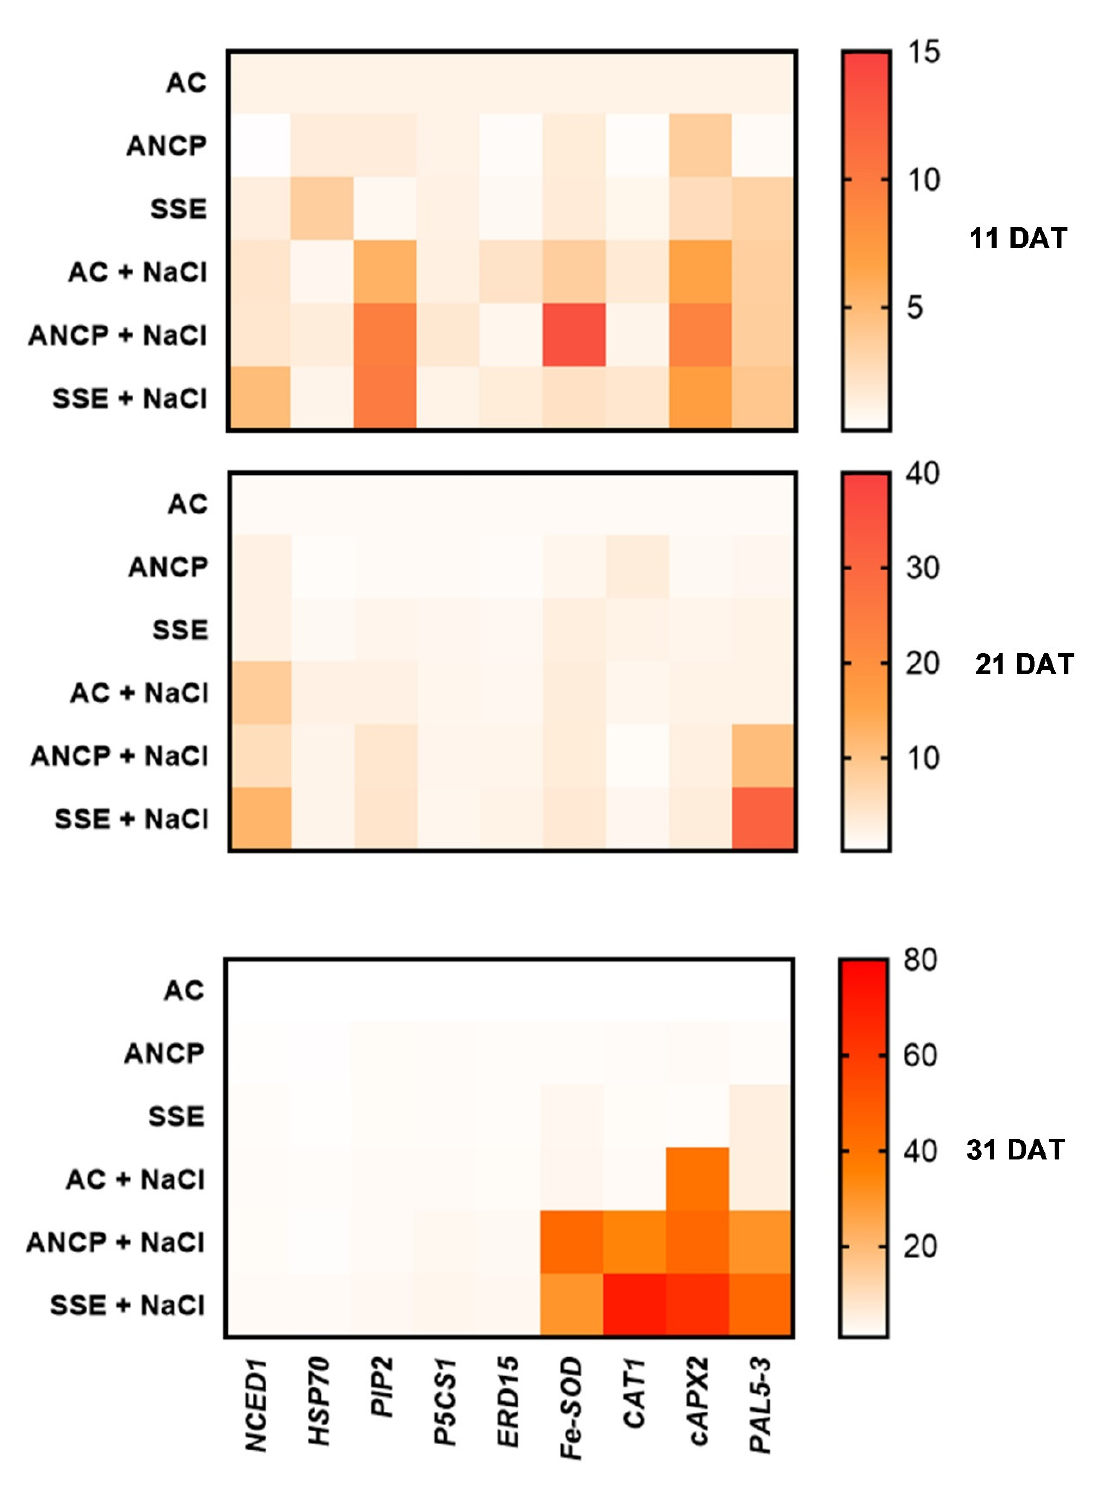
Figure 7. Heatmap of the relative expression of defense genes in leaves of tomato seedlings. DAT: Days after transplant; AC: Absolute control; ANCP: A . nodosum commercial product; SSE: Sargassum spp. seaweed extracts; NaCl: 100 mM sodium chloride; n = 4. The AC represents a constant value of 1 at the expression level.